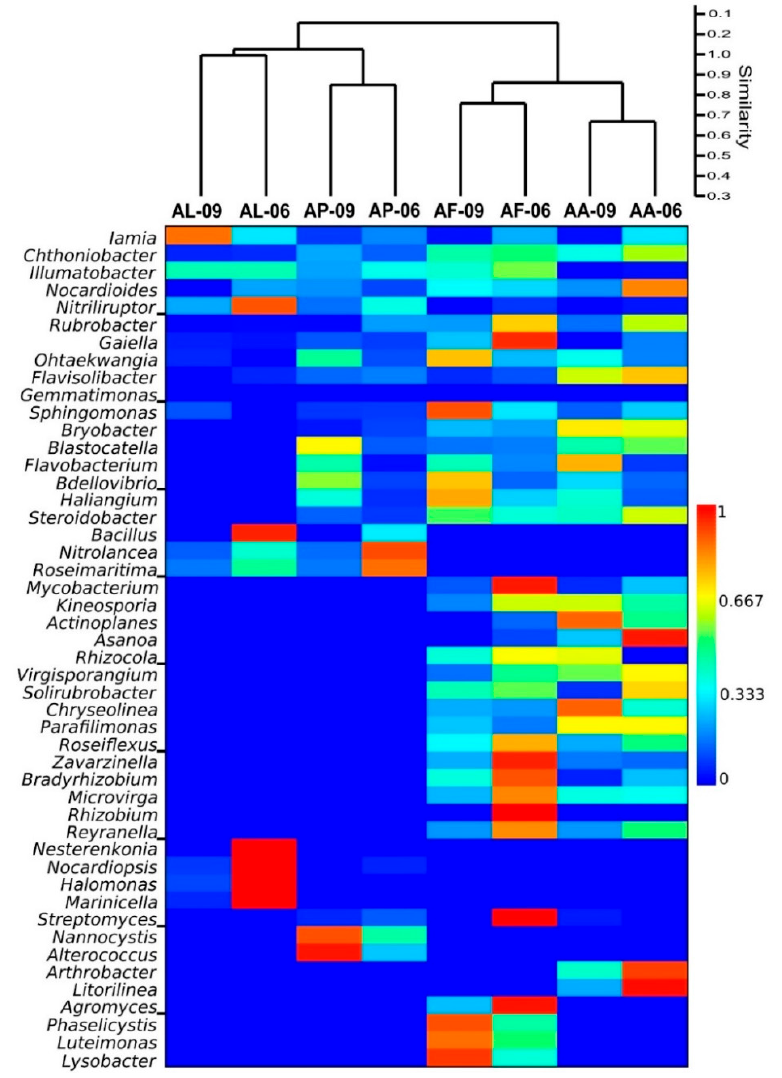
Figure 5. Similarity heatmap of the bacterial genera revealed from pyrosequencing among samples. Sampling sites are given in Table 1.